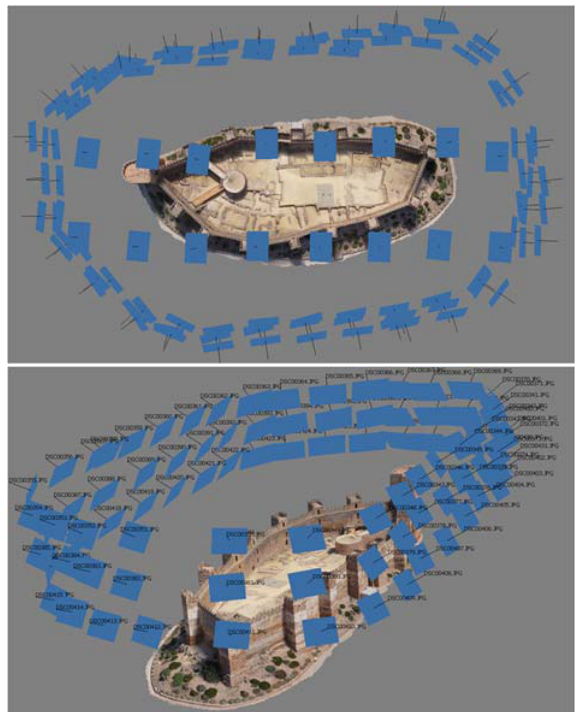
Figure 5. Circular targets used as GCP. A: Target for GPS measurements; B: Aerial view of target A at 50 flying height. C: Target for total station and mini prism pole measurement; D: Target C at 20 m flying height.